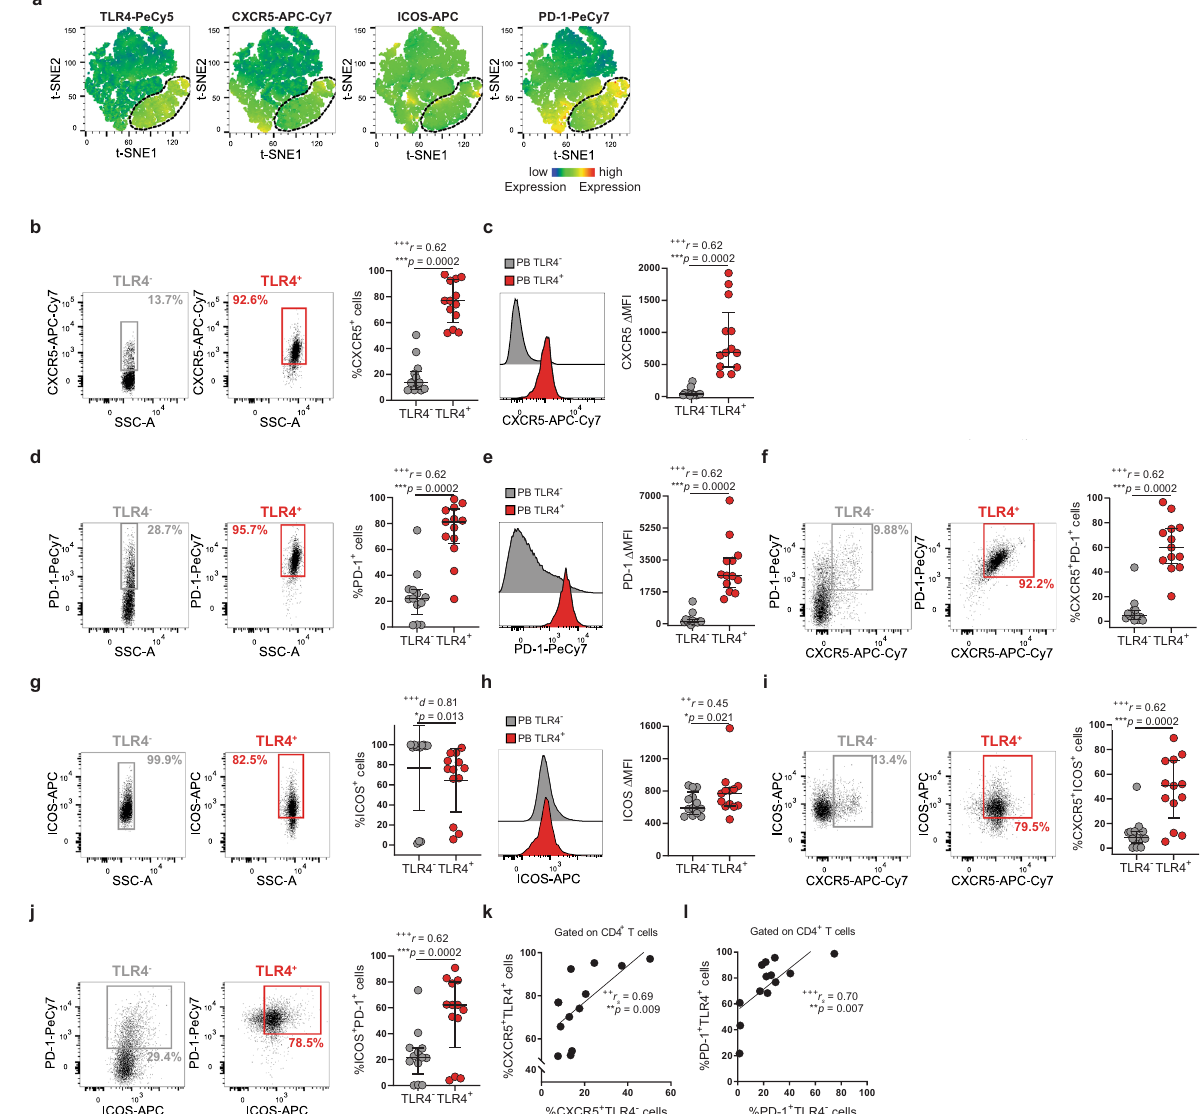
Fig. 6 TLR4 + T cells have features of Tfh-like cells. a t-SNE plots of peripheral blood total CD4 + T cells. The color indicates cell expression levels of labeled markers (TLR4, CXCR5, ICOS, and PD-1). Circle demarks TLR4 + cells ( n = 6 RA patients). b , c Representative plots and cumulative analysis ( n = 13 RA patients) of CXCR5 b frequency and c Δ MFI in TLR4 + (red) versus TLR4 − (gray) T cells. d , e Representative plots and cumulative analysis ( n = 13 RA patients) of PD-1. d frequency and e Δ MFI in TLR4 + (red) versus TLR4 − T cells (gray). f Representative plots and cumulative analysis ( n = 13 RA patients) of the frequency of CXCR5 and PD-1 co-expression TLR4 + (red) versus TLR4 − (gray) T cells. g , h Representative plots and cumulative analysis ( n = 13 RA patients) of ICOS g frequency and h Δ MFI in TLR4 + (red) versus TLR4 − (gray) T cells. i Representative plots and cumulative analysis ( n = 13 RA patients) of the frequency of CXCR5 and ICOS co-expression in TLR4 + (red) versus TLR4 − (gray) T cells. j Representative plots and cumulative analysis ( n = 13 RA patients) of the frequency of ICOS and PD-1 co-expression TLR4 + (red) versus TLR4 − (gray) T cells. k Correlation between the frequency of TLR4 + CXCR5 + T cells and TLR4 − CXCR5 + cells ( n = 13 RA patients). l Correlation between the frequency of TLR4 + PD1 + T cells and TLR4 − PD1 + cells ( n = 13 RA patients). Δ MFI was calculated to correct for the distinct auto fl uorescence of the TLR4 − and TLR4 + T-cell populations. Δ MFI was calculated by subtracting the fl uorescence intensity minus one (FMO) from median fl uorescence intensity (MFI) for each given marker. Data are presented as mean ± SD, for parametric statistical tests, or median ± IQR, for non-parametric statistical tests. Sample normality distribution was tested by using D ’ Agostino & Pearson normality test. P values **** p ≤ 0.0001, *** p ≤ 0.001, ** p ≤ 0.01, * p ≤ 0.05 were determined by ( b – f , h – j ) Wilcoxon matched-pairs rank test; ( g ) Paired t test and ( k , l ) Spearman Correlation. Effect size measures +++ high, ++ medium, + small were determined by ( b – f , h – j ) r – correlation coef fi cient r ; ( g ) d − Cohen ’ s d; and ( k , l ) r s – Spearman ’ s correlation coef fi